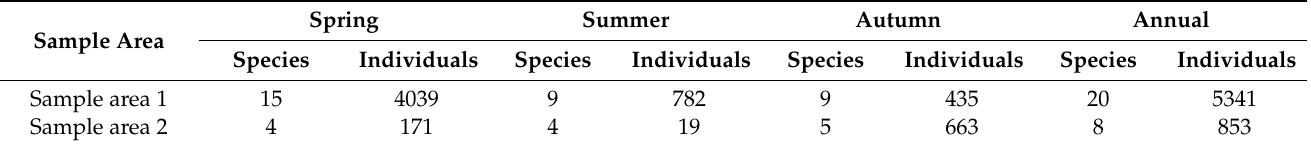
Table 3. Distribution of birds in different